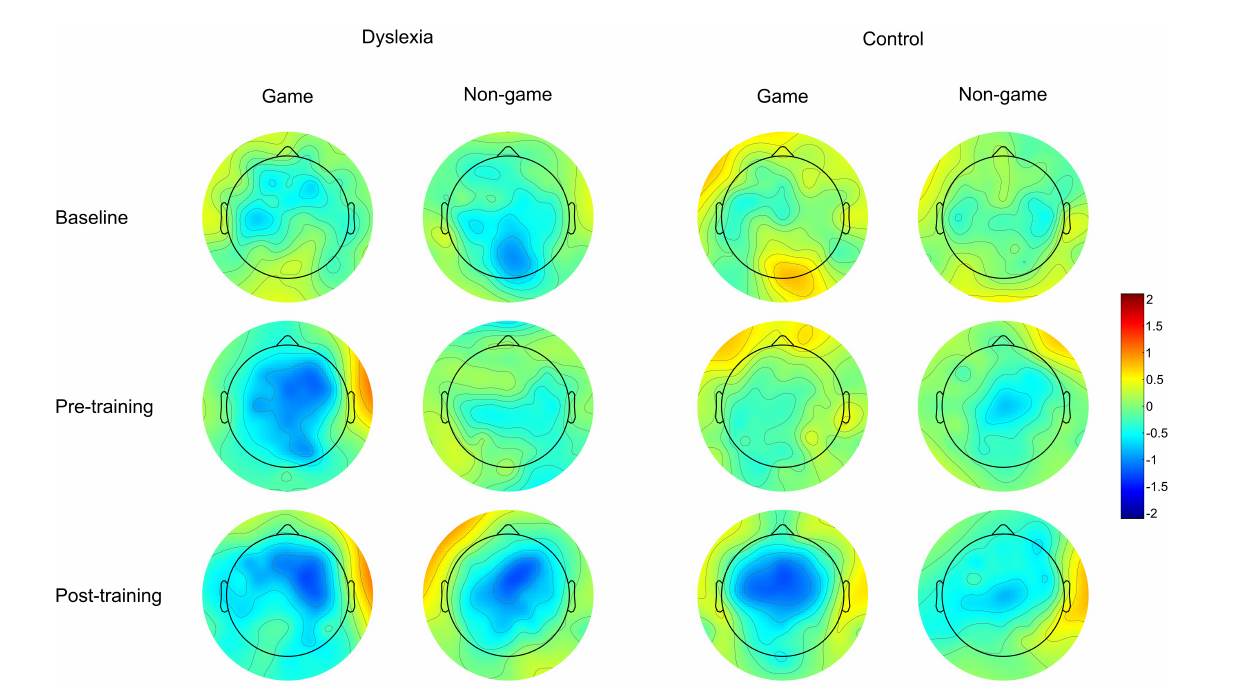
FIGURE6 Scalp topography maps for the MMN response of the dyslexia group and the control group. The scalp topographies are shown at the baseline measurement, pre-training, and post-training. Amplitude is shown in µ V.